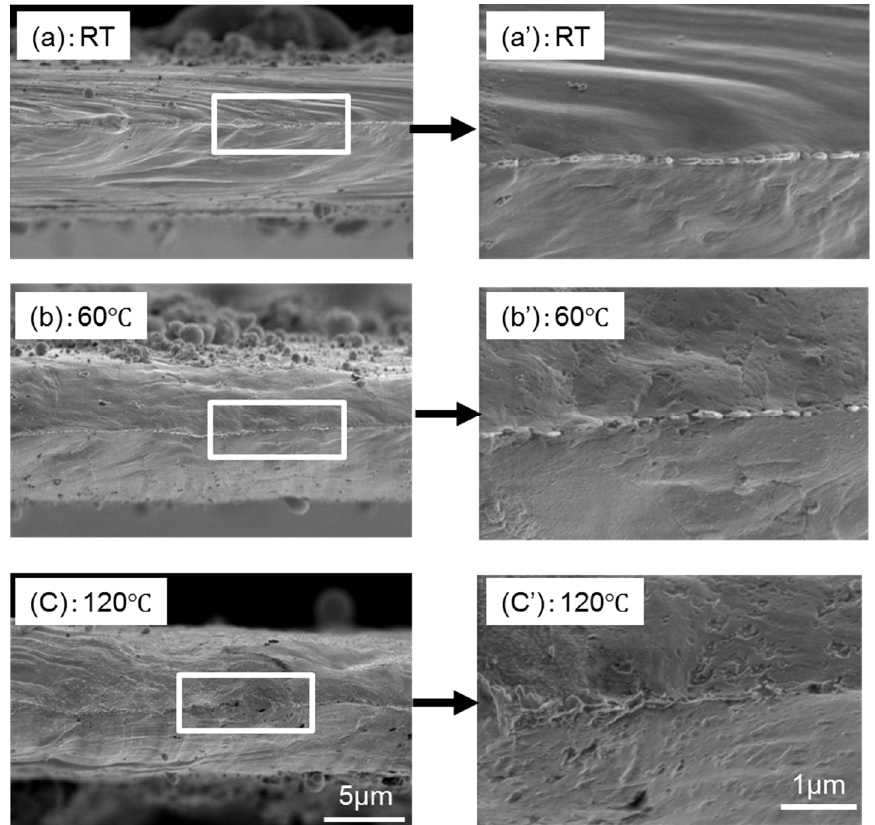
Figure 6. ( a – c ) Representative SEM images of p-Ag fracture surface together after tensile tests at room temperature (RT), 60 ◦ C, and 120 ◦ C, respectively. ( a’ – c’ ) Enlarged SEM images of each area denoted by white square shown in Figure 6a–c.